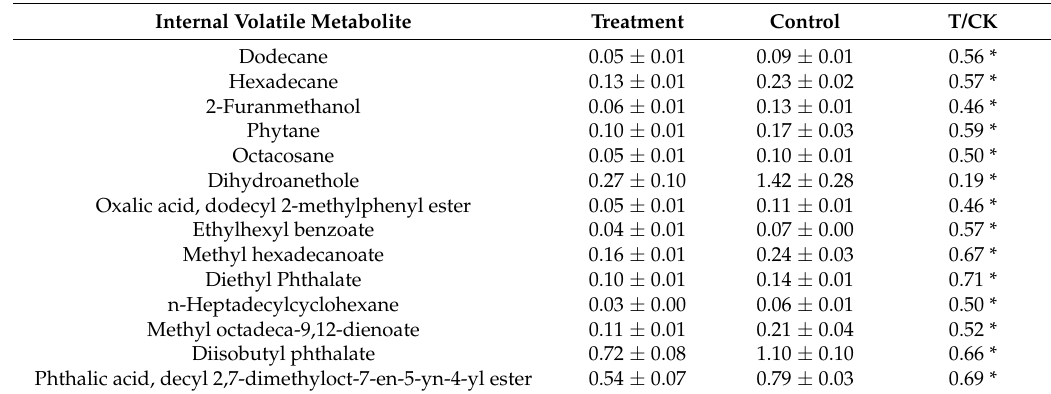
Table 1. Effect of PGR on internal volatiles in C. Radix